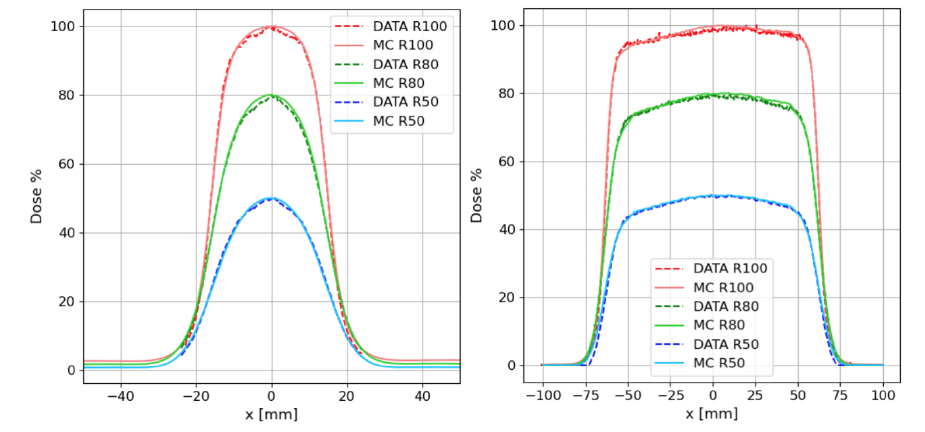
Figure 9. Measured (dotted line) and simulated (continuous line) transverse profile in the PMMA phantom obtained for the 7 MeV electrons beam collimated with the A-d30 ( left ) and A-d120 ( right ) applicators. The figures show the profiles obtained at 12 mm (R100), 17 mm (R80), and 21 mm (R50)